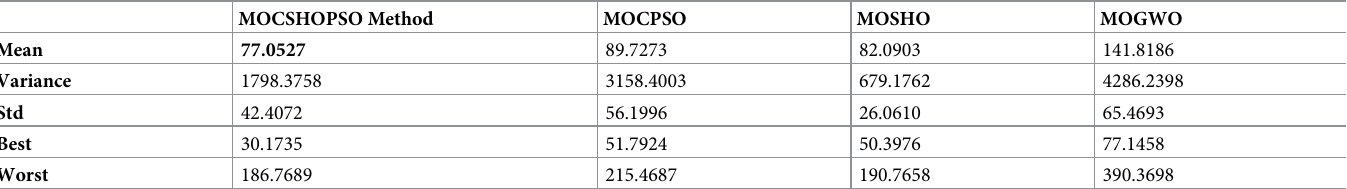
Table 4. Comparative analysis of different algorithms based on the spacing metric.